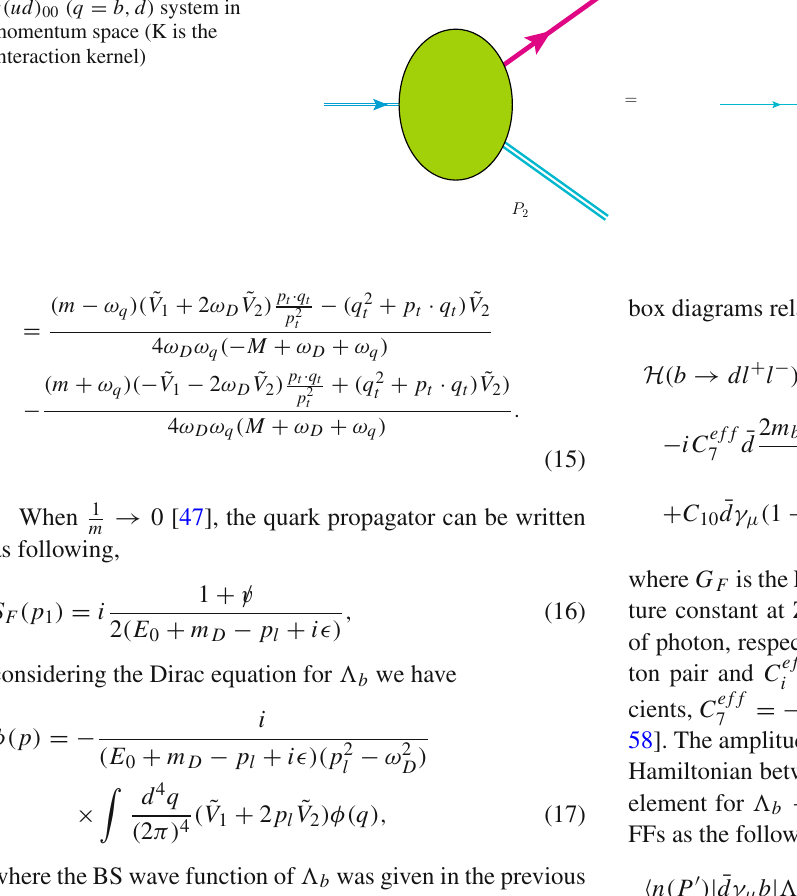
Fig. 1 The BS equation for the q ( ud ) 00 ( q = b , d ) system in momentum space (K is the interaction